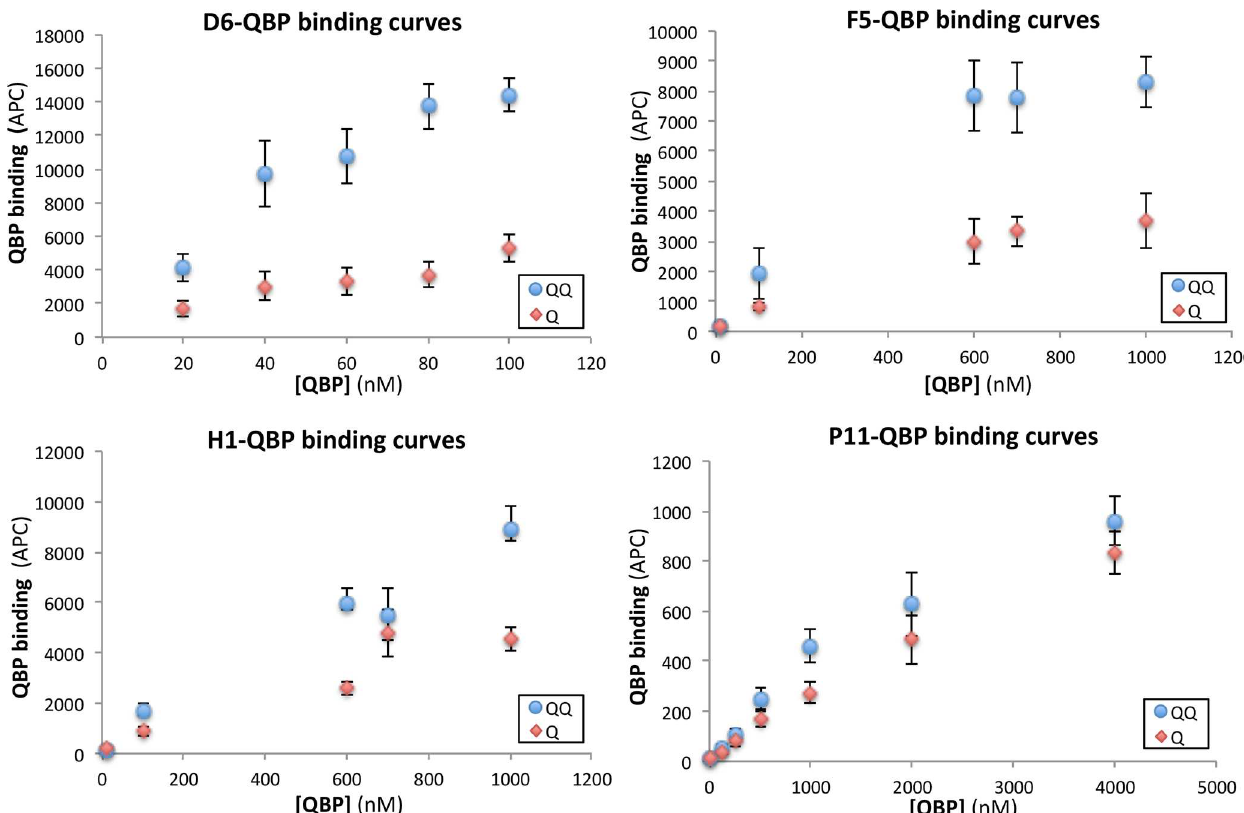
Fig 5. Bindingcurvesfor selectedQBP-binding peptides. Selectedpeptideswere yeast-expressedand assayed by flow cytometryfor bindingto apo (Q)or glutamine-bound (QQ)L-glutamine-bindingperiplasmicproteinQBP at various concentrations. Experiments were executed in duplicateand the data points in each graph are averages of the mean APC fluorescencewith corresponding standarddeviations. The estimatedaffinities fromthis data are D6 = 35 nanoM,F5 = 300 nanoM,and P11 = 2 microM.